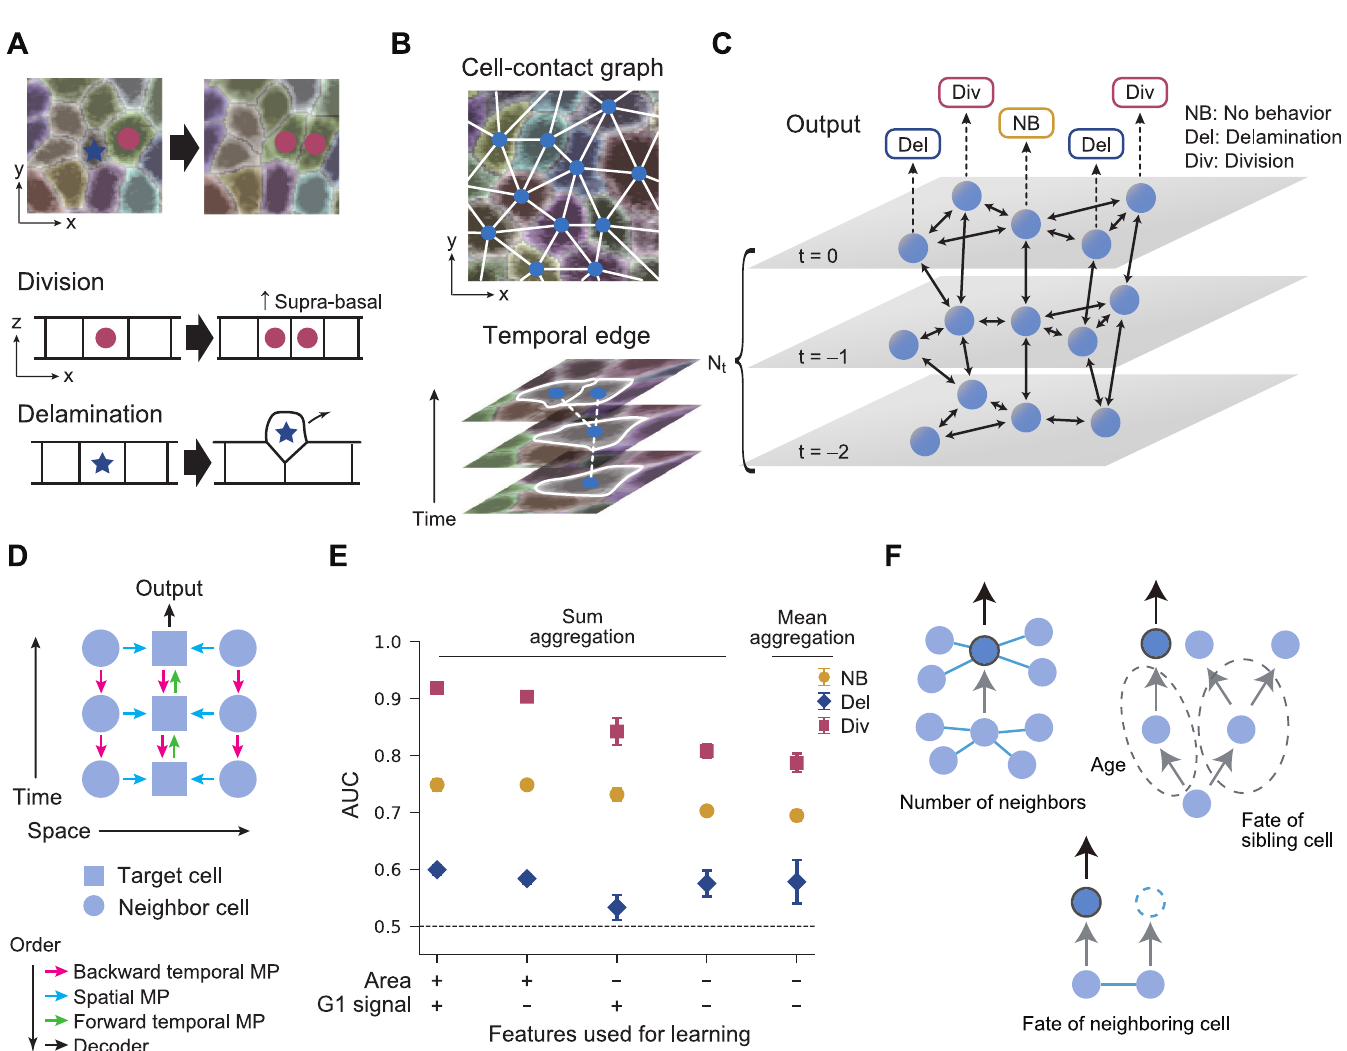
Fig 1. Bidirectional spatiotemporal GNN model: Analysis of the hind paw epidermis data. (A) Schematic of cell division and delamination in the basal layer of the mouse epidermis. (B) Schematic of the cell-contact graph and temporal edges in the basal layer. (C) Schematic of the 2+1 dimensional spatiotemporal graph. A 3-time model is shown as an example. The spheres represent cells, and double-headed arrows represent the neighboring cell connection and the temporal tracks. The GNN models predict the cell fate (NB, Del, Div) conducted in the final layer ( t = 0). (D) Schematic of the information flow in the bidirectional spatiotemporal GNN model. The information flow in a target cell’s subgraph is shown. The target and the neighboring cells are represented by boxes and circles, respectively. Each arrow indicates the direction of the information flow, the order of which is represented by the different colors. (E) The area under the curve score (AUC) of the bidirectional spatiotemporal GNN models with sum and mean aggregation is shown for models under various feature conditions. The AUC for each cell fate label is shown with different markers (NB: circle, Del: diamond, Div: square), which are obtained by averaging over six trained models. Error bar: standard deviation. (F) Graph motifs that are potentially useful in predicting the target cell fate. The correlation of these motifs to the target cell fate can be exploited to make predictions in the bidirectional spatiotemporal GNN model.